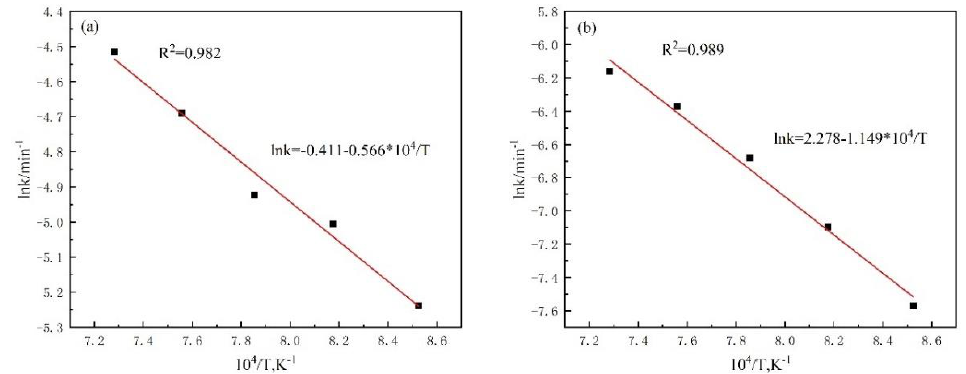
Figure 4. Arrhenius plots of gasification rate constant vs temperature: ( a ) intrinsic chemical reaction control step and ( b ) diffusion control step.